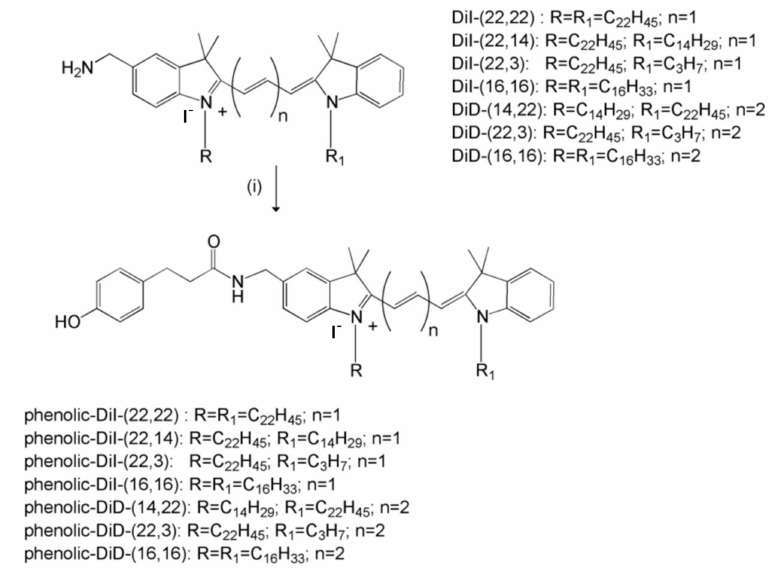
Figure 1. Structures of carbocyanine-based fluorescent probes and their phenolic